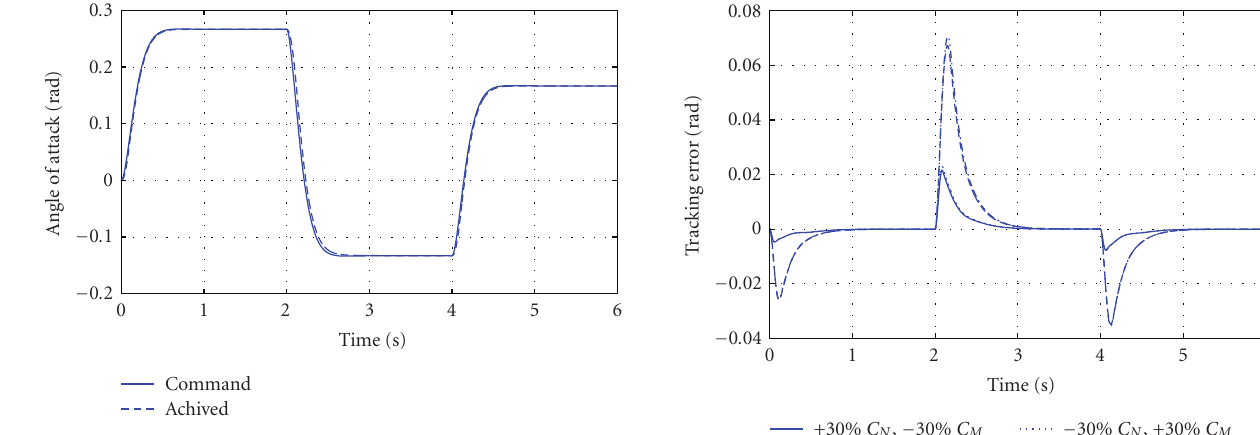
Figure 2: Vehicle response to a sequence of step command.